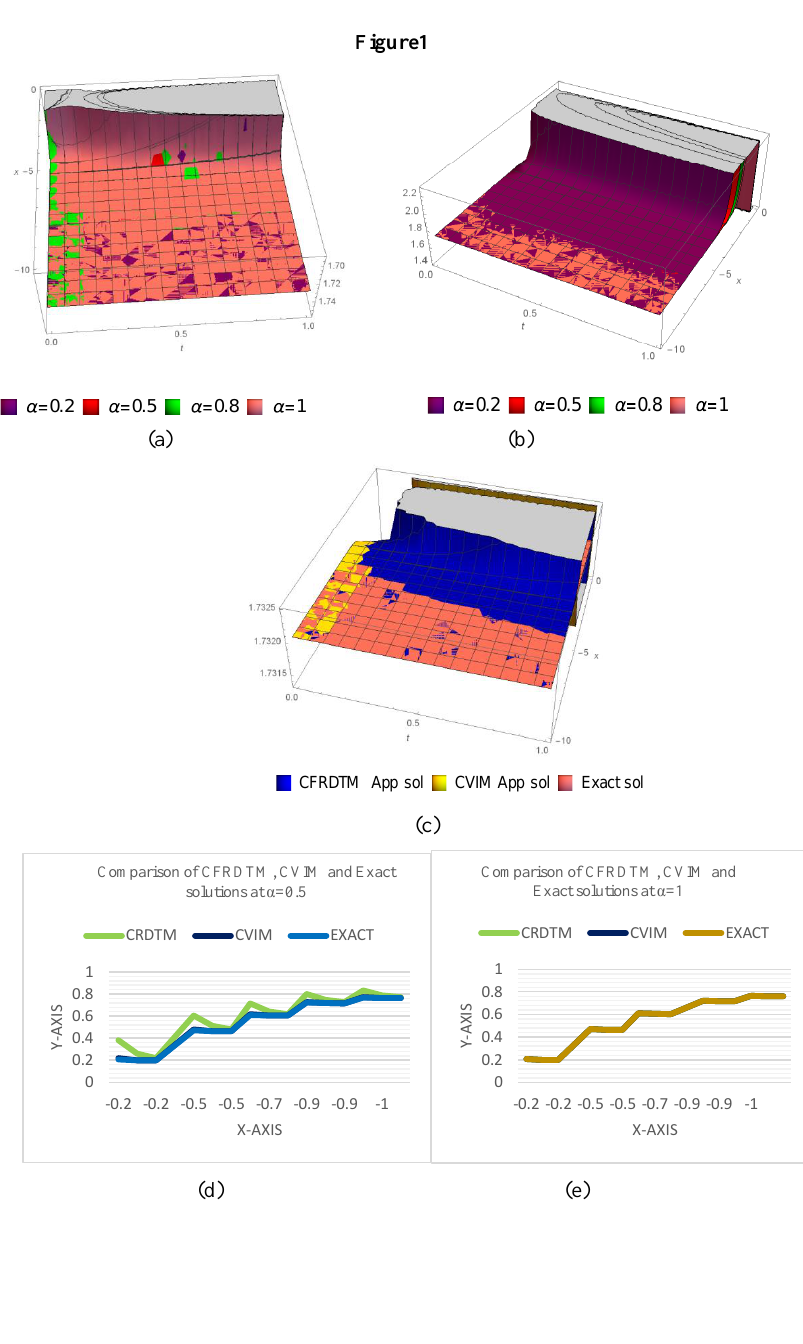
Figure 1: Approximate solution for the foam drainage model Eq. (15) for different values of α with fixed values 0 ≤ t ≤ 1,-10 ≤ x ≤